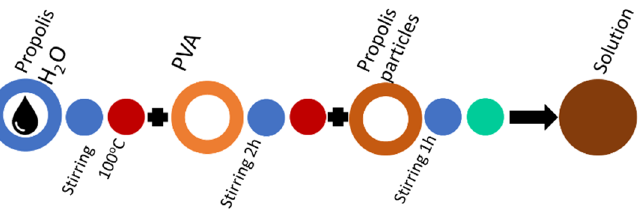
Figure 7. Solution mixing sequence for propolis water and propolis powder integration.